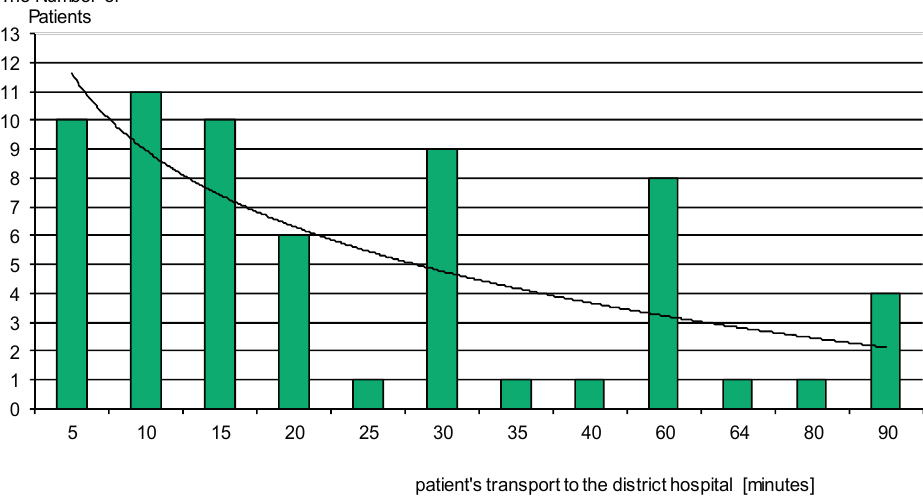
Figure 3. Transportation time of patients with acute coronary syndrome to the district hospital. Patient transport time to the district hospital (stage I transport) ranged from 5 to 90 min. Average patient transport time in the first stage of transport to the hospital is about 28